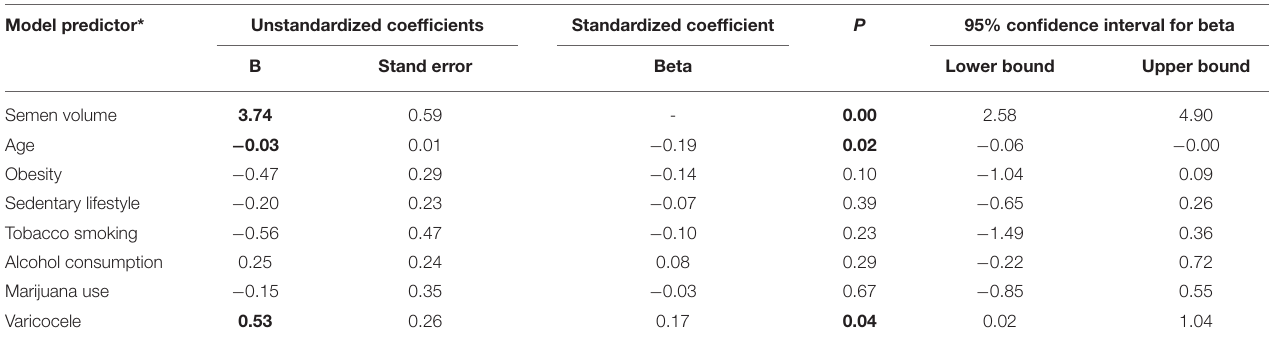
TABLE 8 | Coefficients of the multiple linear regression analysis model for dependent variable Semen volume. Model predictor* Standardized coefficient P Beta Lower